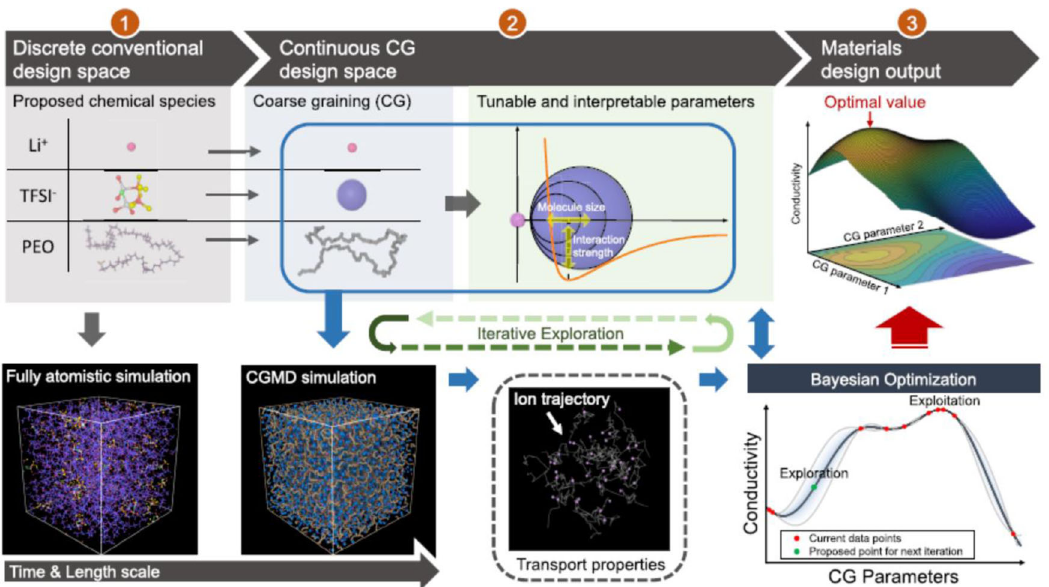
Fig. 4 Schematic illustration of the coarse-grained MD-Bayesian ML method for optimizing conductivity of polymer electrolytes (reproduced from Wang et al. 75 ). In this approach, using the coarse-graining process, new materials are designed (stage 2) using the discrete chemical species (anions, backbone polymers, and secondary site of polymers) obtained from stage 1. Afterward, the relationship for properties was predicted using the